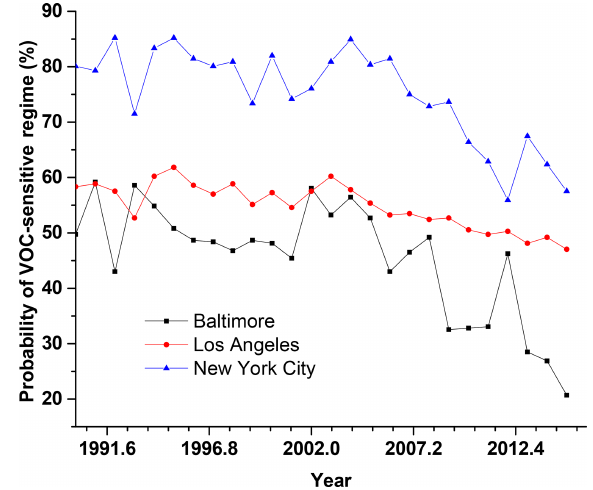
Figure 11. Long-term trends in probability of VOC-sensitive pho- tochemical production of surface ozone in three major urban areas at 14:00LT in July. Probability is calculated using averages of 3 × 3 grids centered at